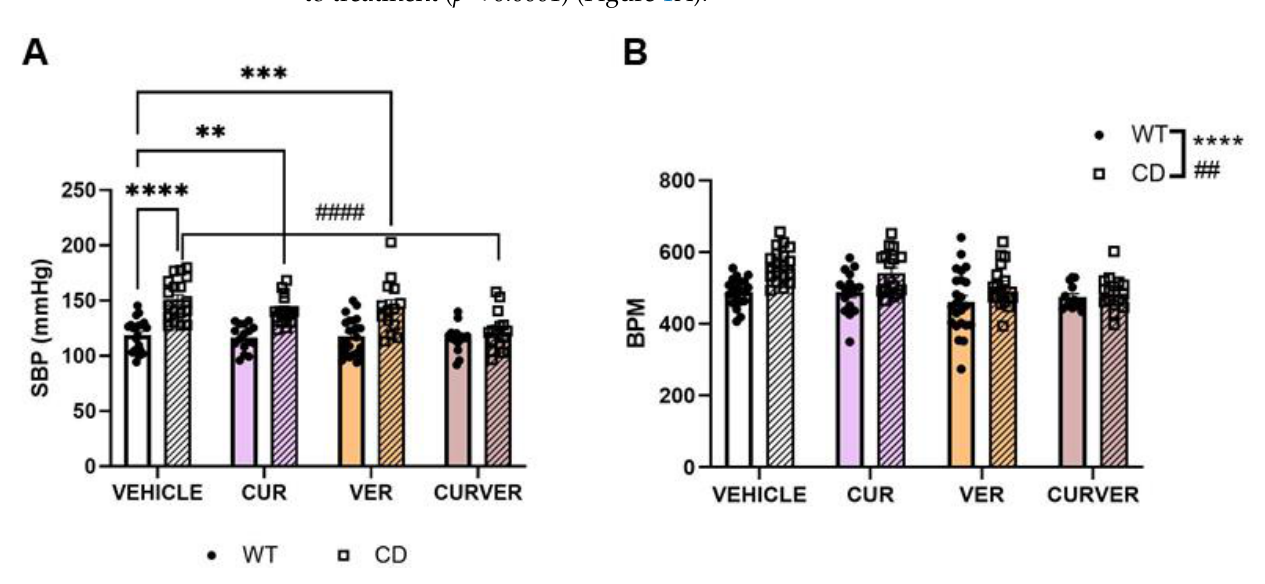
Figure 1. CURVER treatment normalises SBP and BPM in CD mice. ( A ) SBP and ( B ) BPM mea- surements in the conscious state using the indirect tail-cuff method in WT and CD mice treated with single or combined treatments. CURVER-treated CD mice showed significantly decreased SBP com- pared with CD-vehicle mice ( p < 0.0001). A significant effect of genotype and treatment was ob- served for BPM without any significant interaction between factors (F 3, 133 = 1.692, p = 0.1718). Data are represented as mean ± SEM. Two- way ANOVA with Tukey’s multiple comparisons test. * Effect of genotype; #, effect of treatment. **, ## p < 0.005; *** p < 0.001; ****, #### p < 0.0001.